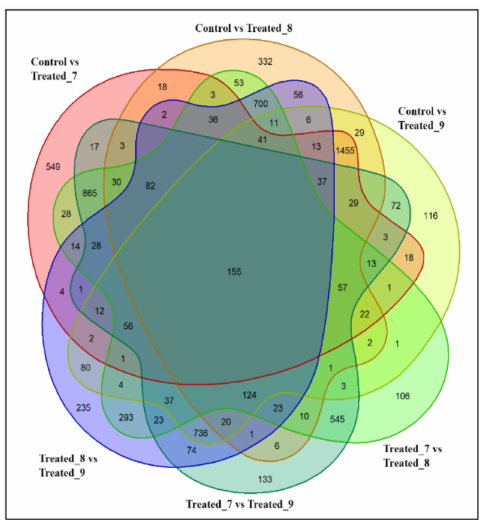
Figure 5. Venn diagram showing comparative expression of metabolites during 100 mM SA stressed condition in A. polystachya